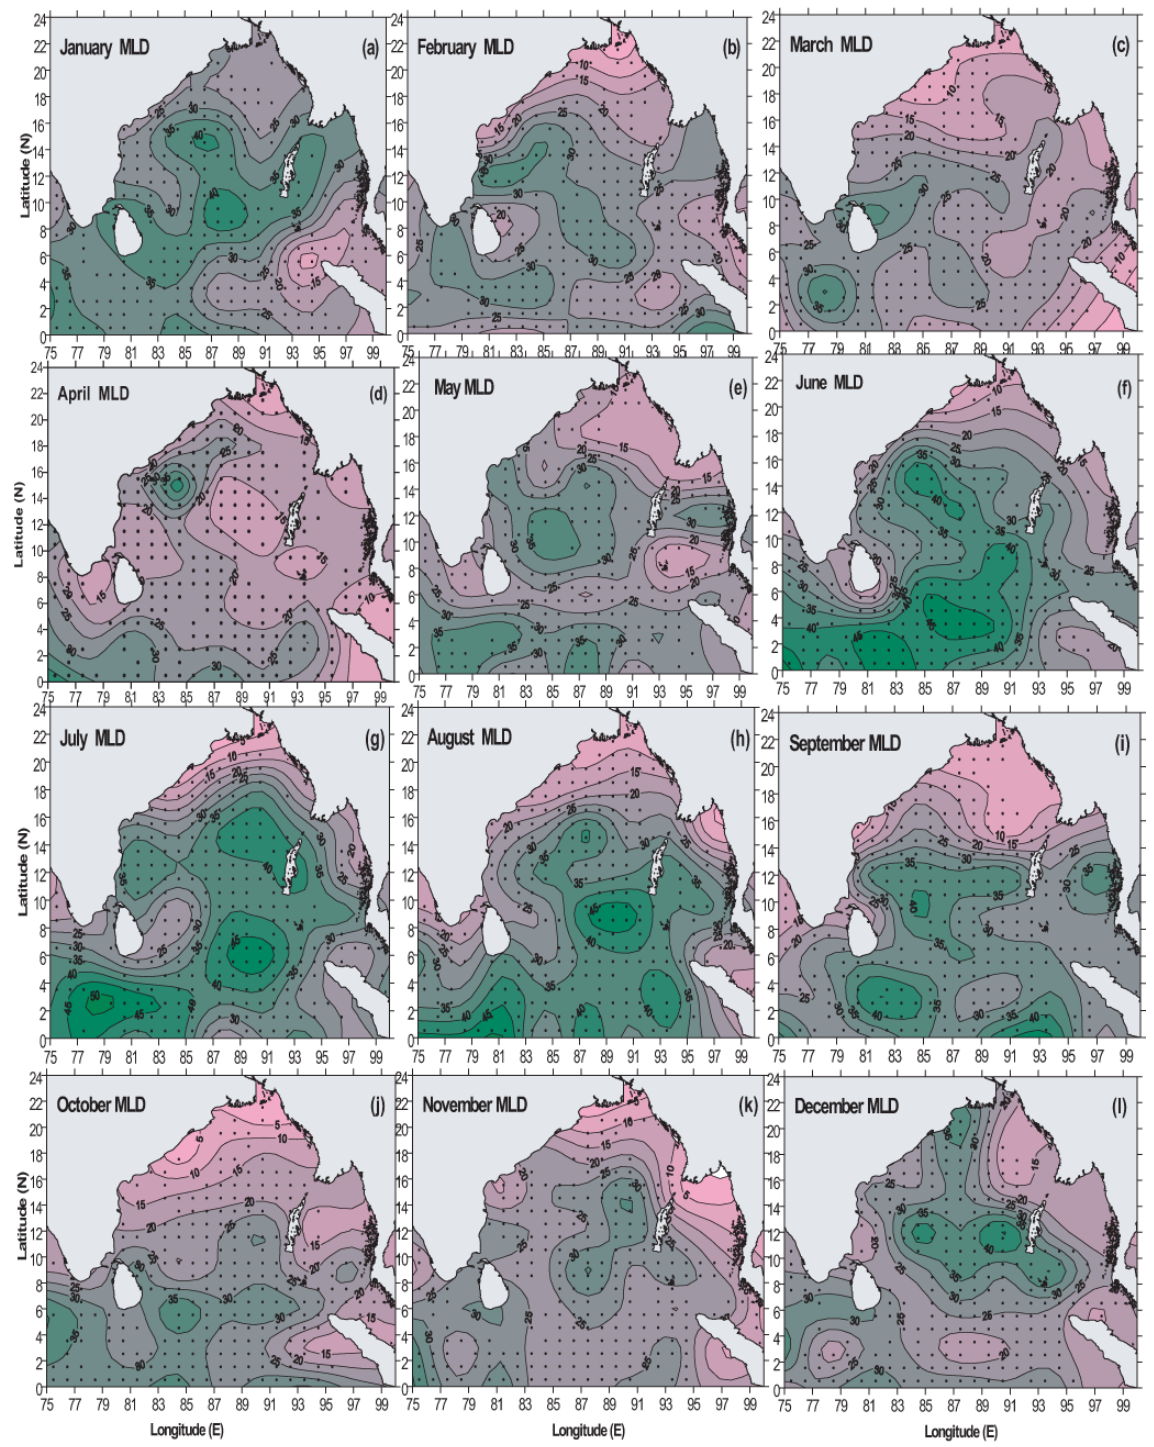
Figure A1. Monthly mean climatology of the mixed layer depth (MLD, m) from January to